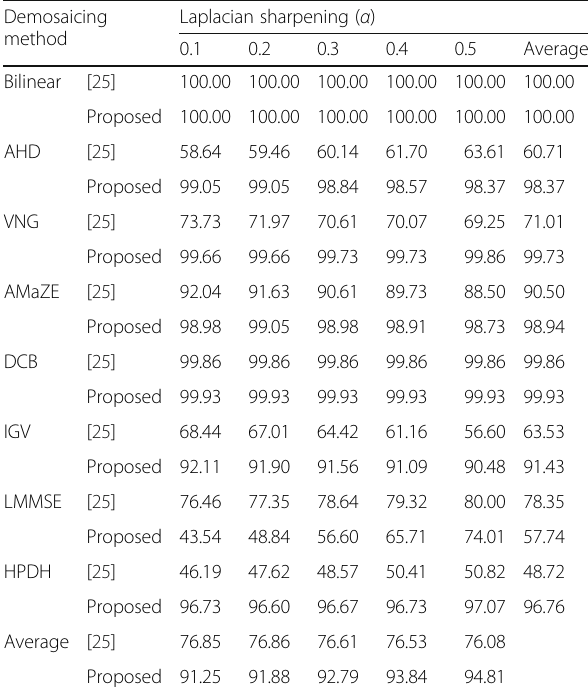
Table 7 Estimation accuracy comparison between conventional algorithm and proposed method with Laplacian sharpening for different demosaicing methods (unit %). Block size fixed